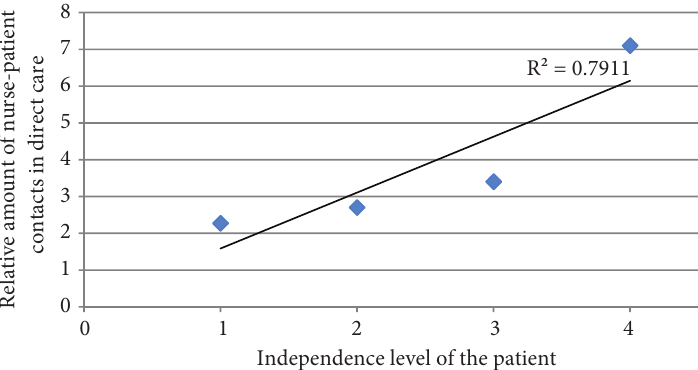
Figure 1. The relationship between the amount of direct nursing care, based on the relative number of nurse-patient contacts and patients’ level of independence in medical units of a